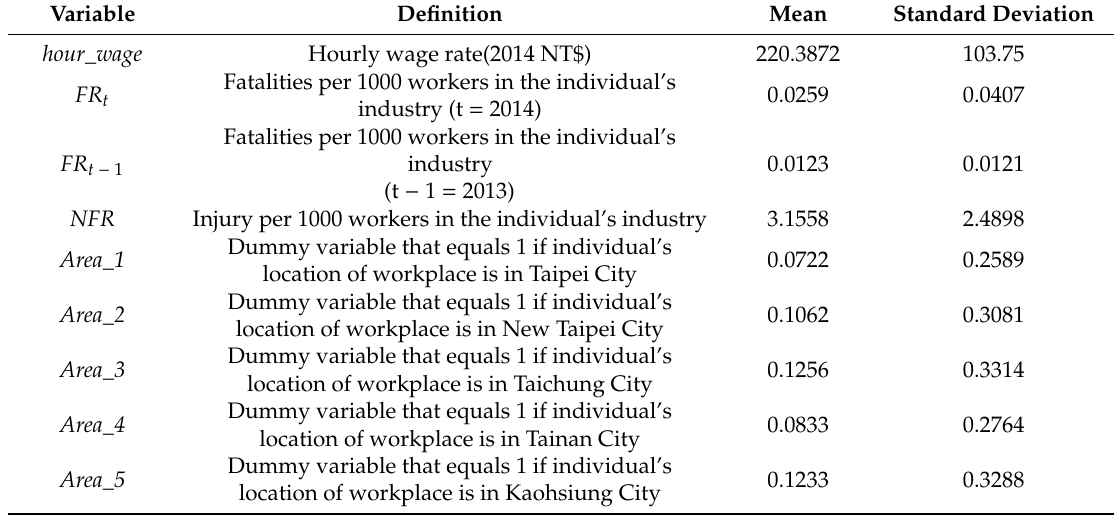
Table 1. Empirical variables and Summary